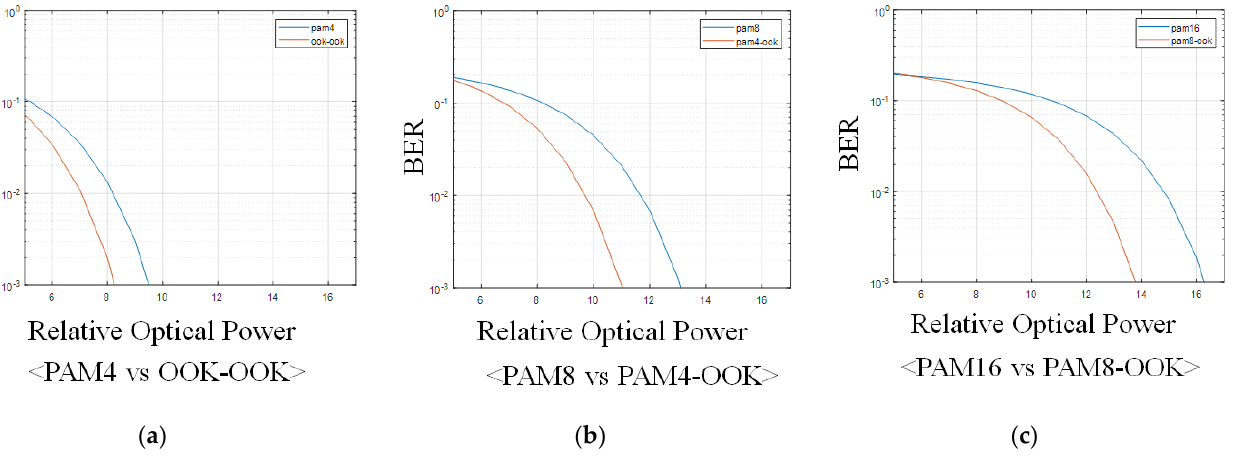
Figure 5. Relative optical power vs. BER graph for the proposed technique and MPAM. ( a ) PAM4 vs. OOK − OOK; ( b ) PAM8 vs. PAM4 − OOK; ( c ) PAM16 vs. PAM8 − OOK.